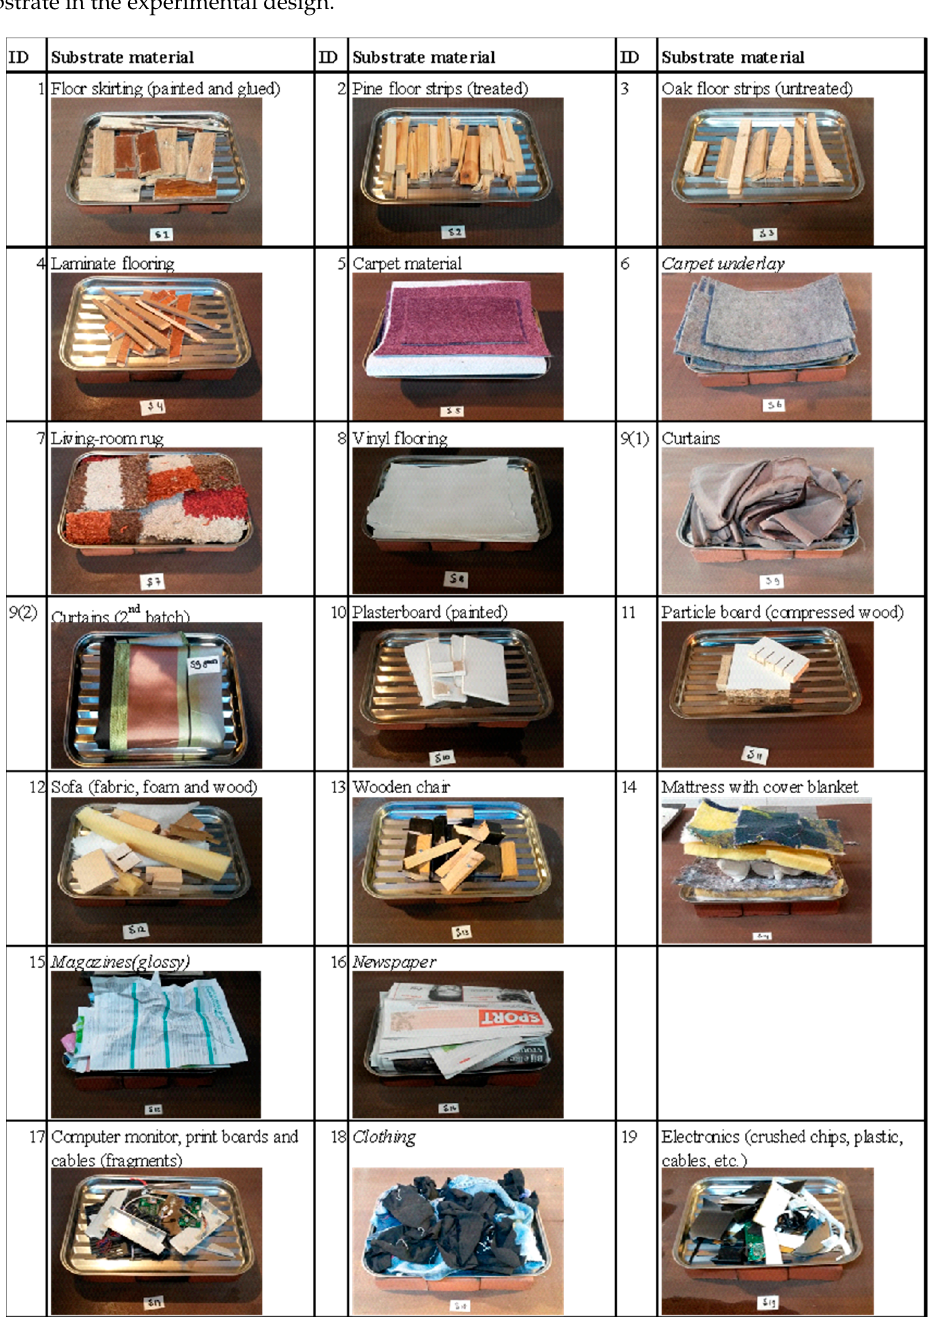
Table 1. List of substrates used in the burn experiments. Most of the materials were obtained second hand through personal contacts (e.g., left-over floor skirting) and the same batch of material was used throughout, except for curtain material (two batches). Items in italic script were not used as primary substrate in the experimental design.